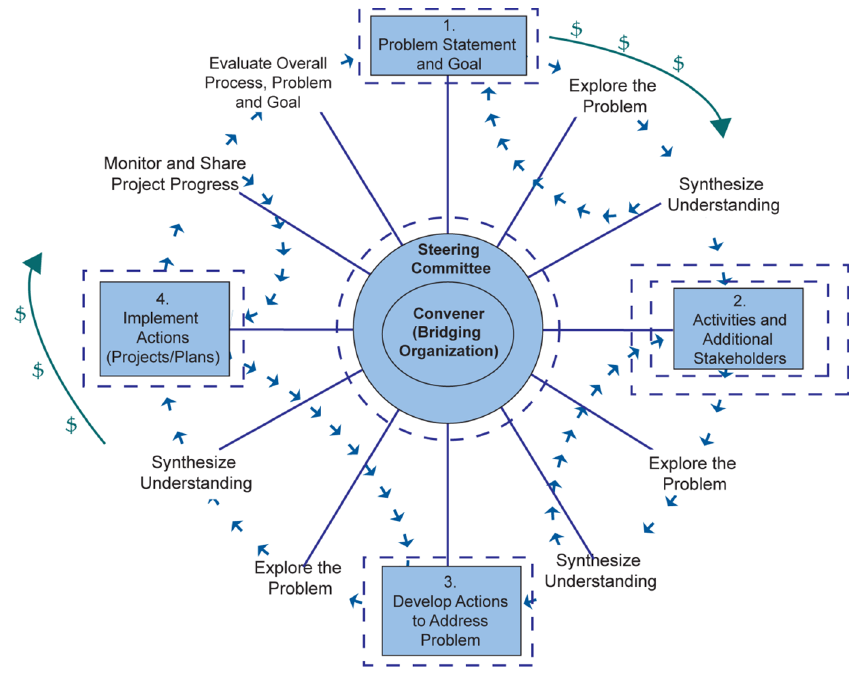
Figure 2. Stakeholder Engagement Wheel.